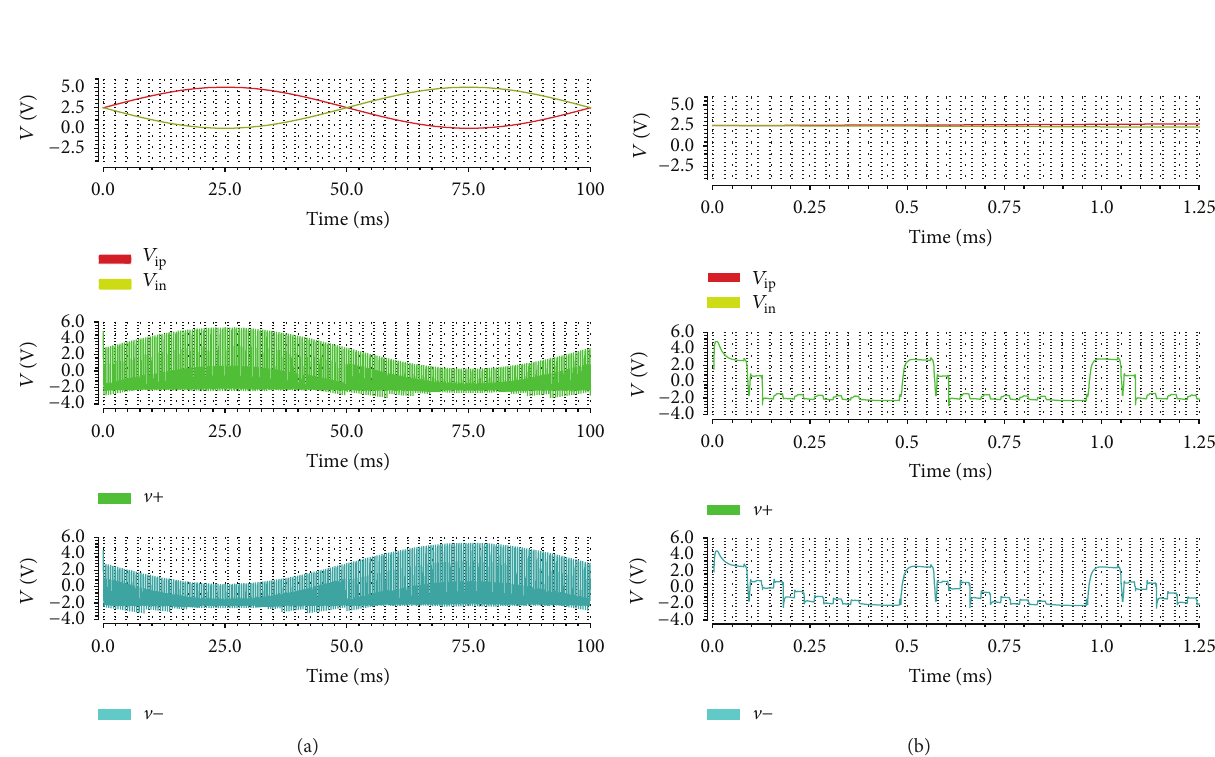
∗ Excluding circuits on FPGA. a Simulated and measured results. † Simulation data with Spice level 1. ‡ Measured data. b Measured results. c Simulation results with Spice level 61.